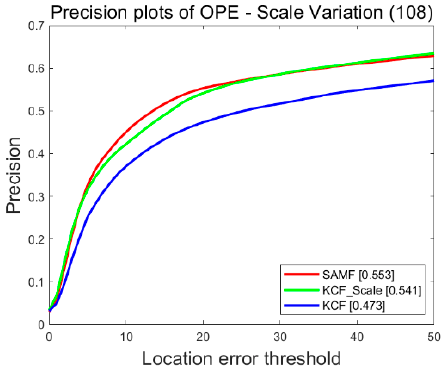
Figure 6. Experimental results of scale improvement.